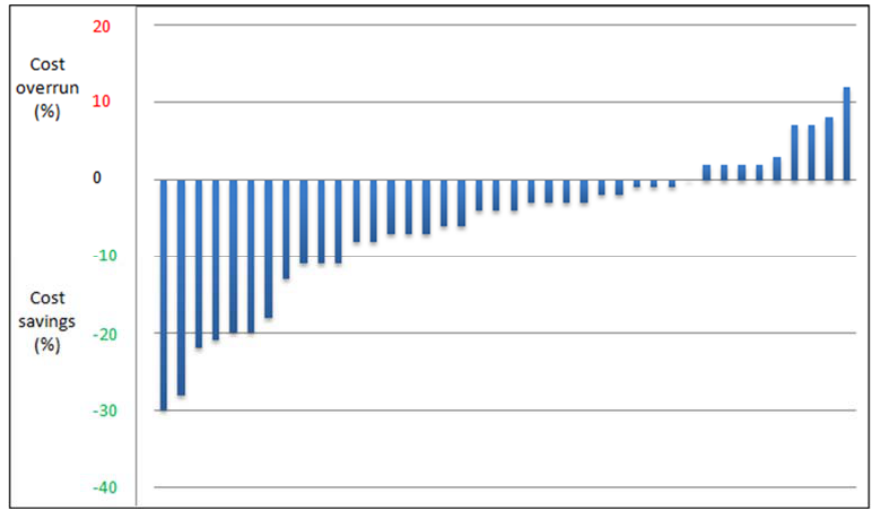
Figure 6. Result from a series of test prognoses of the final costs of Danish motor road projects. The figure illustrates the actual project costs in proportion to the expected project cost (the mean value) from the analyses. The downward bars are savings compared with the predicted mean value, while the upward bars are overruns compared with the predicted mean value. For example, less than 10% means that the final cost was 10% lower than the analyzed mean value. The likely reason for the majority of savings is explained in the text (from Lichtenberg